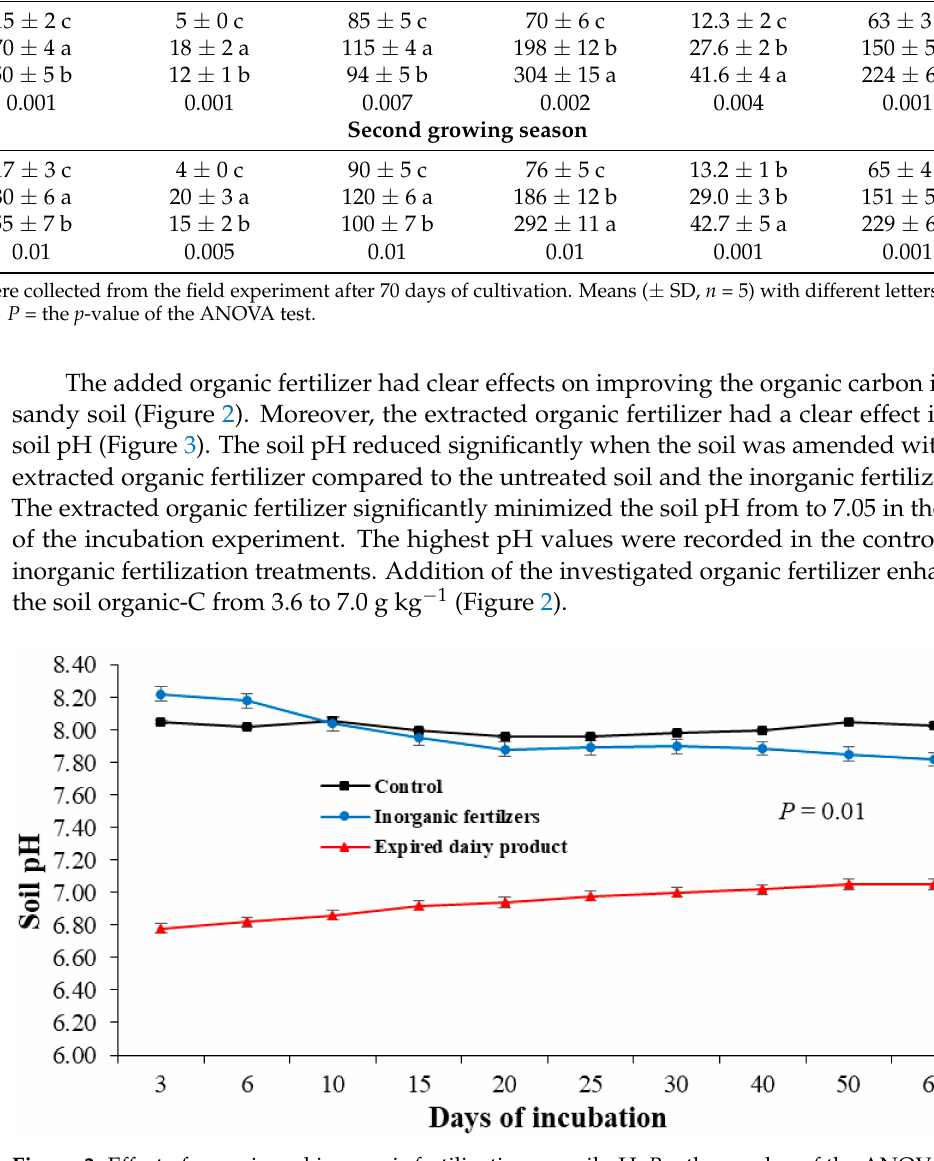
Figure 3. Effect of organic and inorganic fertilization on soil pH. P = the p -value of the ANOVA test. Addition of organic fertilizer to the tested sandy soil increased the soil available N and P by 13% and 83% compared to the full mineral nutrition at the end of the incubation experiment. The obtained results of the incubation experiment for the release of N, P, and K are shown in Figure 3. Nitrogen and potassium release from the organic and inorganic treatments showed the same behavior, and both of the two treatment were higher than the control. The P availability of the organic fertilizer was higher than the inorganic one in the incubation periods above 25